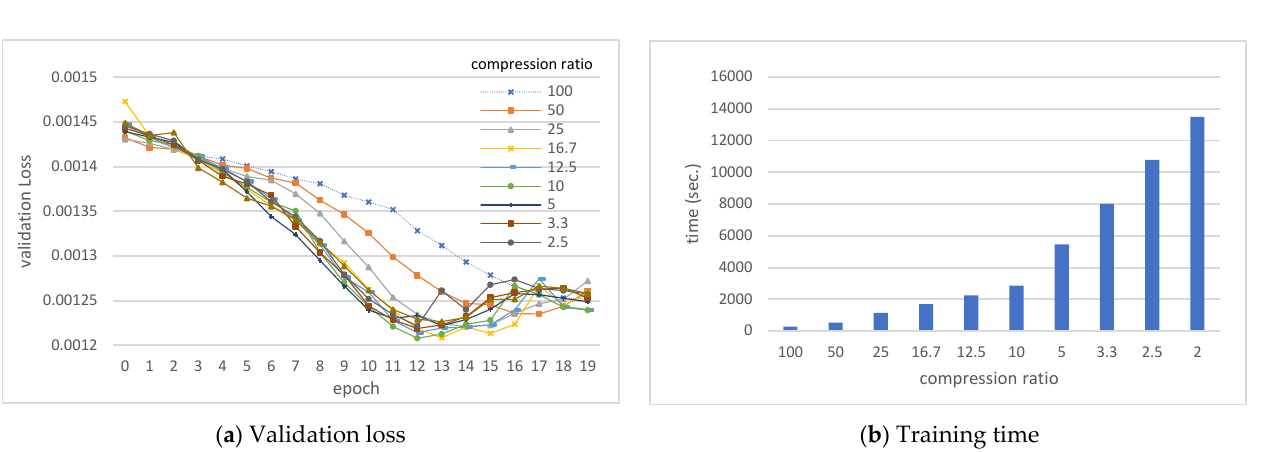
Figure 4. Experiments for the number of nodes in the hidden layers of the DAE. Second, the number of nodes in the latent representation layer is also changed according to a set of compression ratios. Figure 5a shows the relationship between the validation loss and epoch for compression ratios 100, 125, 166.6, 250, 500, and 1000. At the first several epochs, the validation loss is significant for high compression ratio cases. After that, the loss decreases slowly for all compression ratios. However, the computational time for evaluating item similarity in Equation (4) will be much longer if a small compression ratio is applied. Figure 5b illustrates the computational time for item similarity evaluation for several compression ratios. Note that compression ratio 1 indicates no DAE feature reduction function is applied. When no feature reduction is used, the time for item similarity evaluation is 11.49 seconds (i.e., the vector’s dimension is 16,444). Significantly, it takes only 2.87 seconds to complete the item similarity calculation if the dimension of the vector is reduced to 164 (i.e., the compression ratio is 100). Therefore, considering the computational efficiency and model accuracy, the number of nodes in the latent representation layer is suggested as 164. Besides, the experiment shows that applying DAE for feature reduction in the proposed system can significantly shorten the item similarity evaluation time while keeping the essential characteristics of the original features.